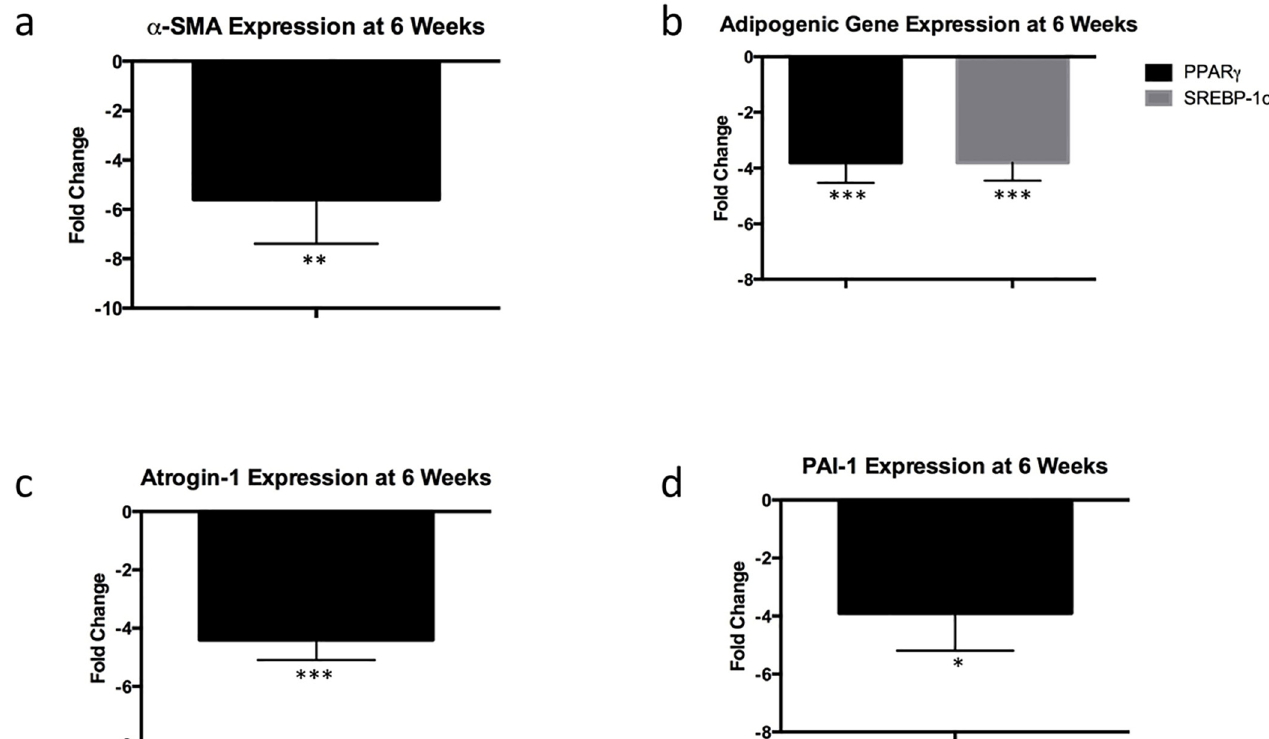
Fig 4. SB431542 decreases expression of fibrotic, adipogenic, and atrophy-related genes. (a) Fold change of α -SMA in injured muscle, SB431542 treatment compared to vehicle. (b) Fold changes of PPAR γ and SREBP-1. (c) Fold change of atrogin-1. (d) Fold change of PAI-1. N = 6 animals/group, 3 technical replicates/animal. * p < 0.05, ** p < 0.01, *** p <